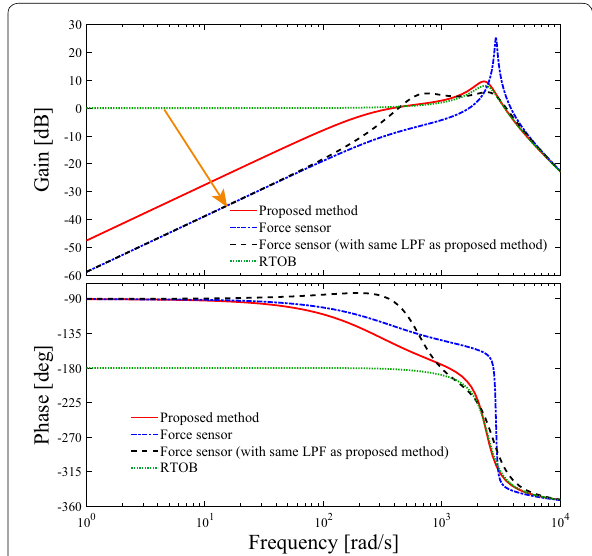
Fig. 7 Bode diagram of the transfer functions from load torque to output external torque